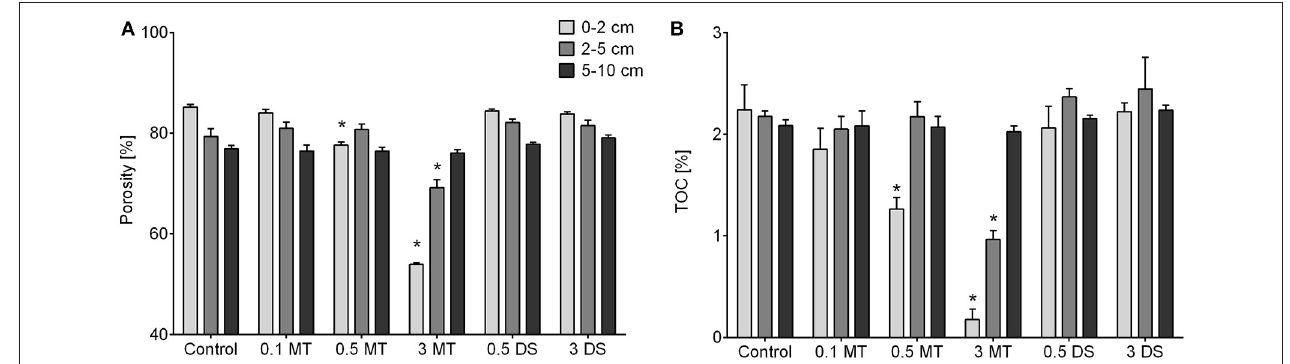
FIGURE 3 | (A) Porosity and (B) total organic carbon (TOC) content of all depth layers per treatment. Error bars denote standard error and an asterisk indicates significant ( p < 0.05) differences with the control. Abbreviations: 0.1 MT = 0.1 cm mine tailing addition, 0.5 MT = 0.5cm mine tailing addition, 3 MT = 3cm mine tailing addition, 0.5 DS = 0.5cm dead sediment addition, 3 DS = 3 cm dead sediment